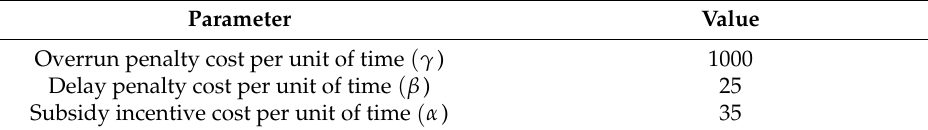
Table 10. Other parameters.